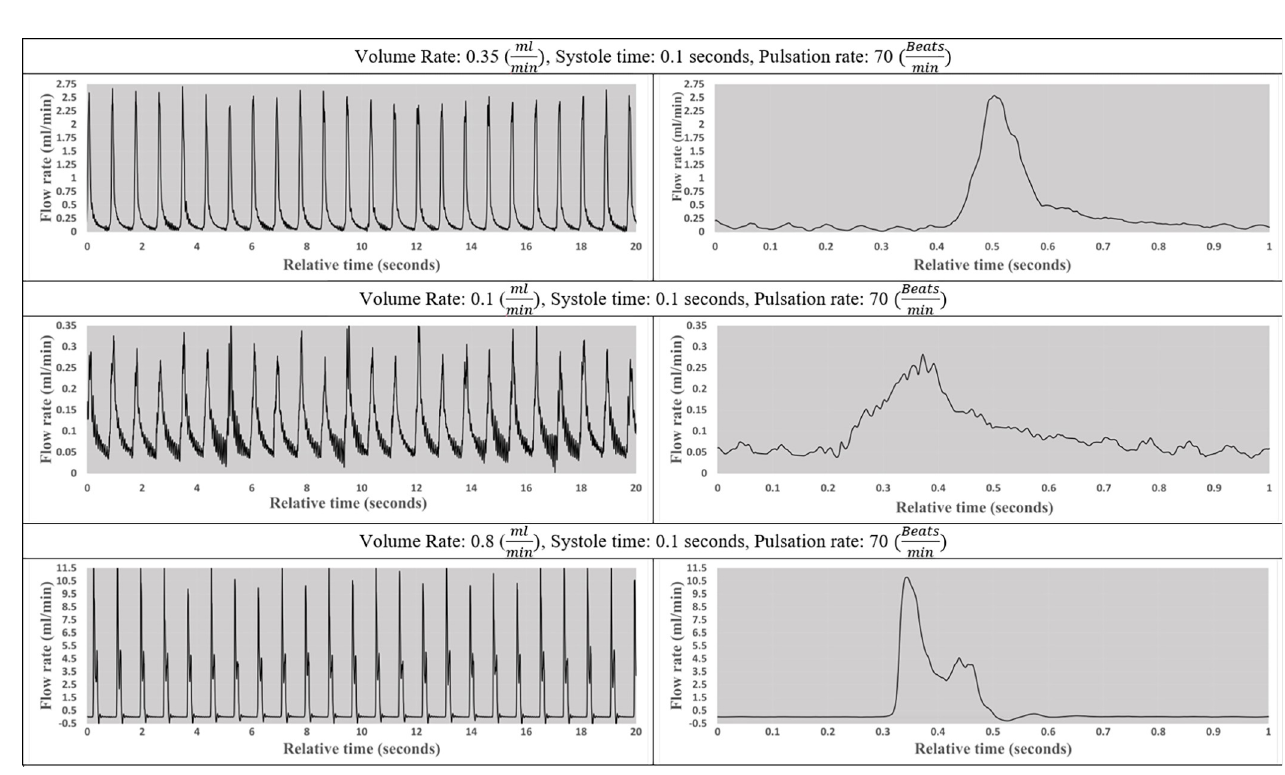
Fig 4. The impact of bulk flow rate on flow pattern. Visual representation of flow pattern of 0.35, 0.1, and 0.8 ml remained